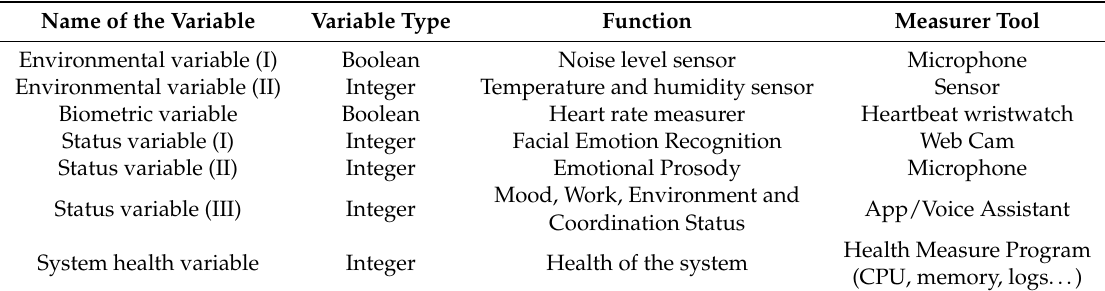
Table 1. Variables from Employee Information Extraction Point.